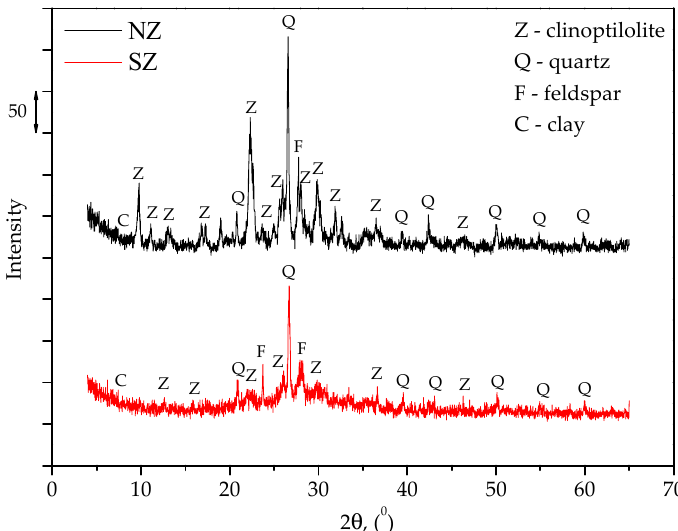
Figure 3. XRPD spectra for NZ and SZ.